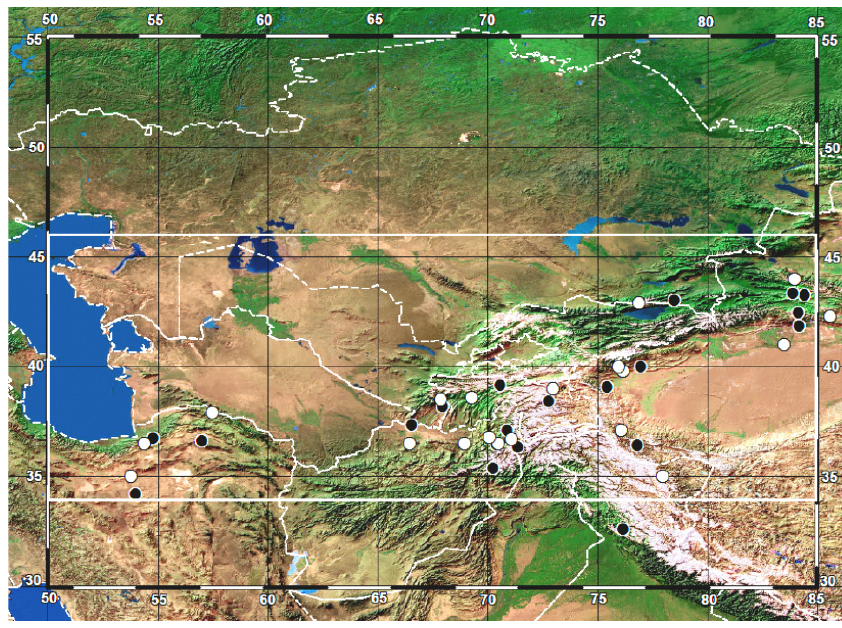
Figure 8. Earthquakes with location in ISC-GME catalogue (black) more than 40 km distant from the location in EMCA (white).